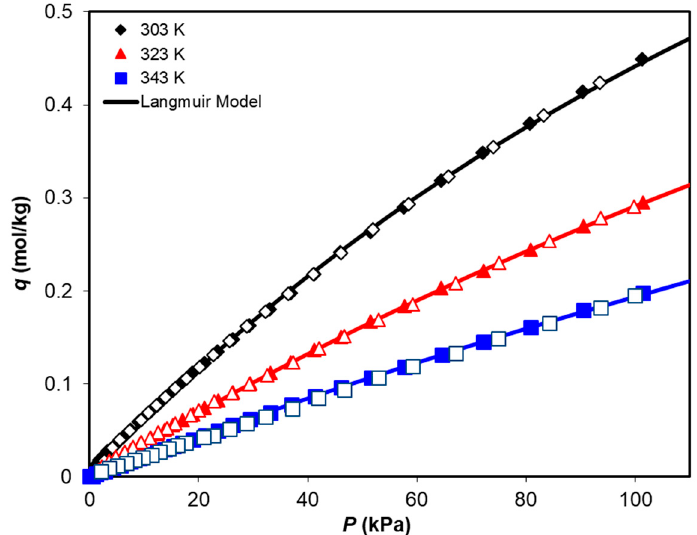
Figure 7. Adsorption equilibrium isotherms of CH 4 on ZSM-5 extrudates at 303, 323, and 343 K. The filled symbols denote adsorption data and open symbols denote desorption data. Solid lines represent Langmuir model fitting.